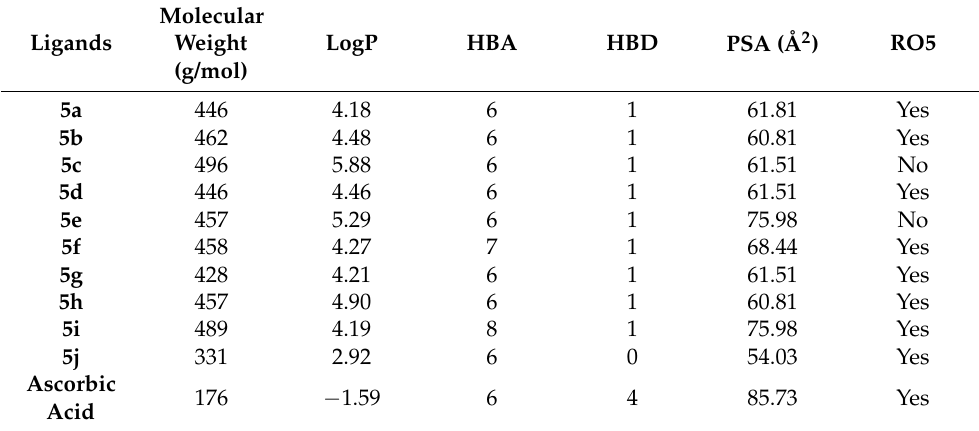
Table 3. RO5 analysis of designed furan-oxadiazole